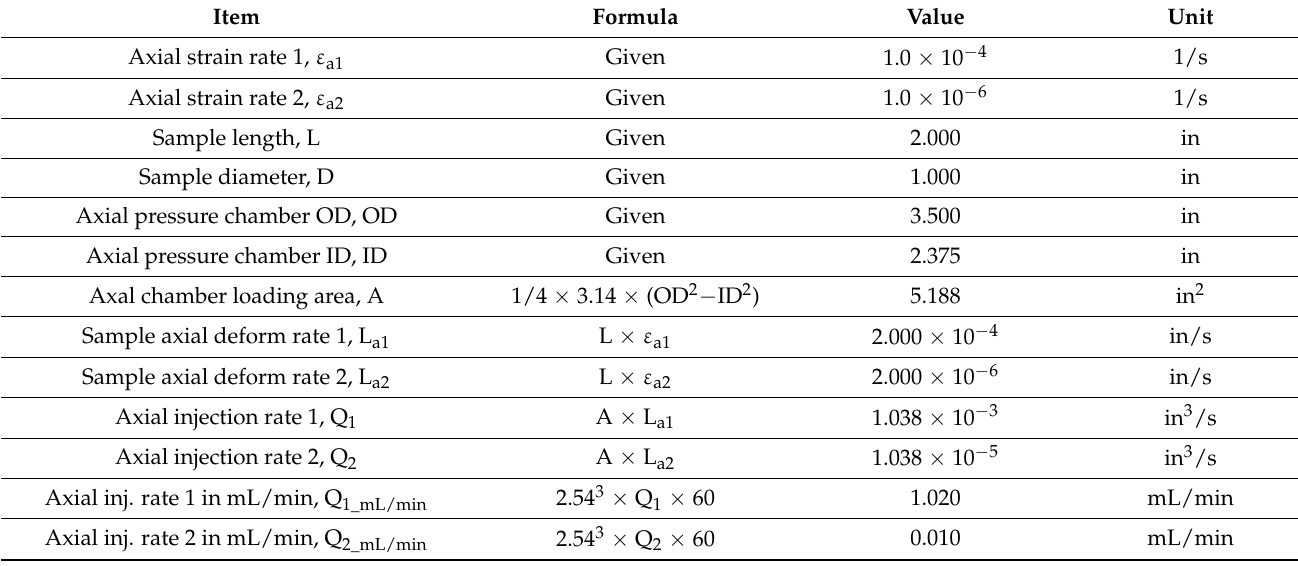
Table A1. Calculation of axial loading pump injection